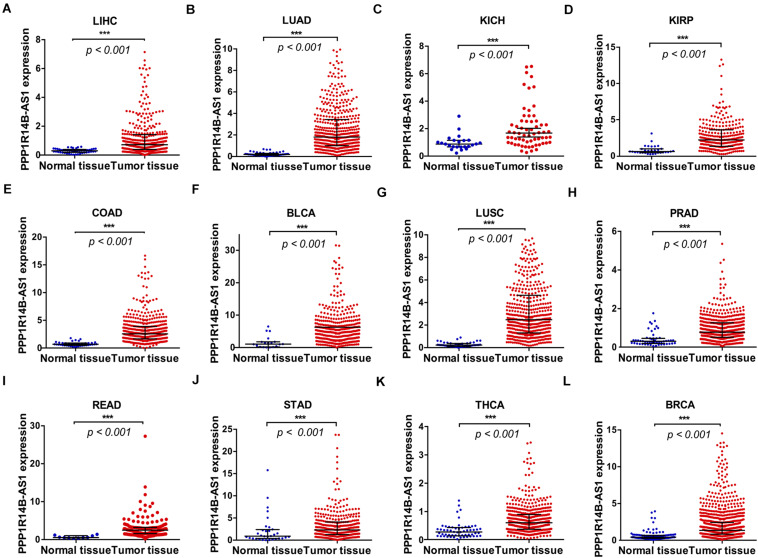
PPP1R14B-AS1 was overexpressed in 12 cancer tissues. PPP1R14B-AS1 RNA-seq FPKM data in the (A) normal tissues (n = 50) and tumor tissues (n = 374) of patients with LIHC. (B) Normal tissues (n = 59) and tumor tissues (n = 533) of patients with LUAD. (C) Normal tissues (n = 24) and tumor tissues (n = 85) of patients with KICH. (D) Normal tissues (n = 32) and tumor tissues (n = 289) of patients with KIRP. (E) Normal tissues (n = 41) and tumor tissues (n = 480) of patients with COAD. (F) Normal tissues (n = 19) and tumor tissues (n = 414) of patients with BLCA. (G) Normal tissues (n = 49) and tumor tissues (n = 502) of patients with LUSC. (H) Normal tissues (n = 52) and tumor tissues (n = 499) of patients with PRAD. (I) Normal tissues (n = 10) and tumor tissues (n = 166) of patients with READ. (J) Normal tissues (n = 32) and tumor tissues (n = 375) of patients with STAD. (K) Normal tissues (n = 58) and tumor tissues (n = 510) of patients with THCA. (L) Normal tissues (n = 113) and tumor tissues (n = 1109) of patients with BRCA. Data were presented as median ± interquartile range and analyzed through Mann–Whitney test, ***p < 0.001.